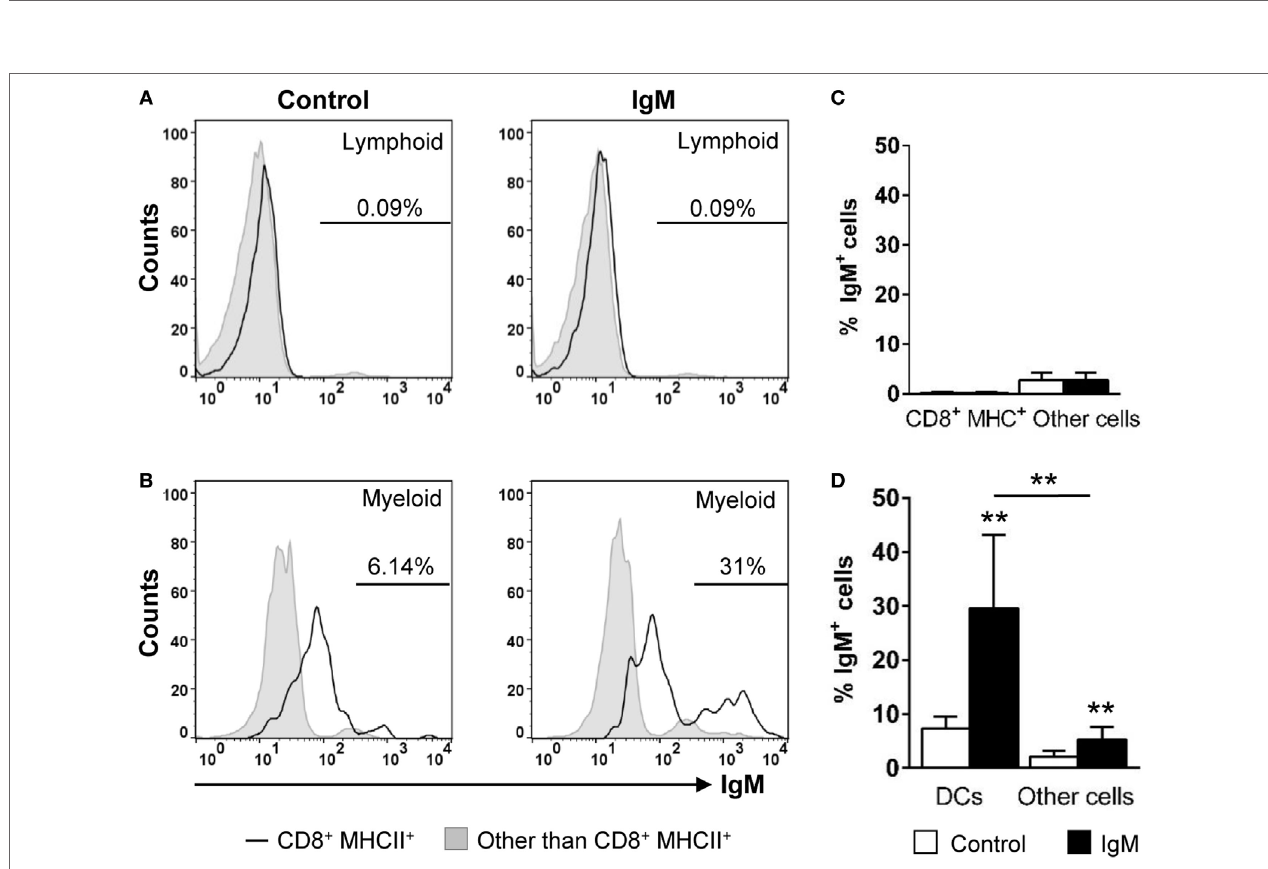
FigUre 6 | IgM-binding capacity of gill CD8 + dendritic cells (DCs). Gill leukocytes were incubated with purified IgM for 1 h at 20°C. Thereafter, cells were stained with specific Abs against CD8 α , major histocompatibility complex (MHC) II, and IgM and analyzed by flow cytometry. Leukocytes were gated as lymphoid (a) and myeloid (B) cells on the basis of their FSC and SSC. Then, CD8 + MHC II + cells were further gated on those populations, and the IgM-binding capacity determined in CD8 + DCs (open line histograms) and compared against the general levels of IgM binding in lymphocytes and myeloid cells (filled line histograms). Data represent the IgM + cells population after exclusion of negative cells present on the isotype controls. (c,D) Average percentage of IgM + cells (left panels) and the MFI of IgM (right panels) within lymphoid (c) and myeloid (D) cells are shown. Data are representative of seven individual fish from two independent experiments (** p ≤